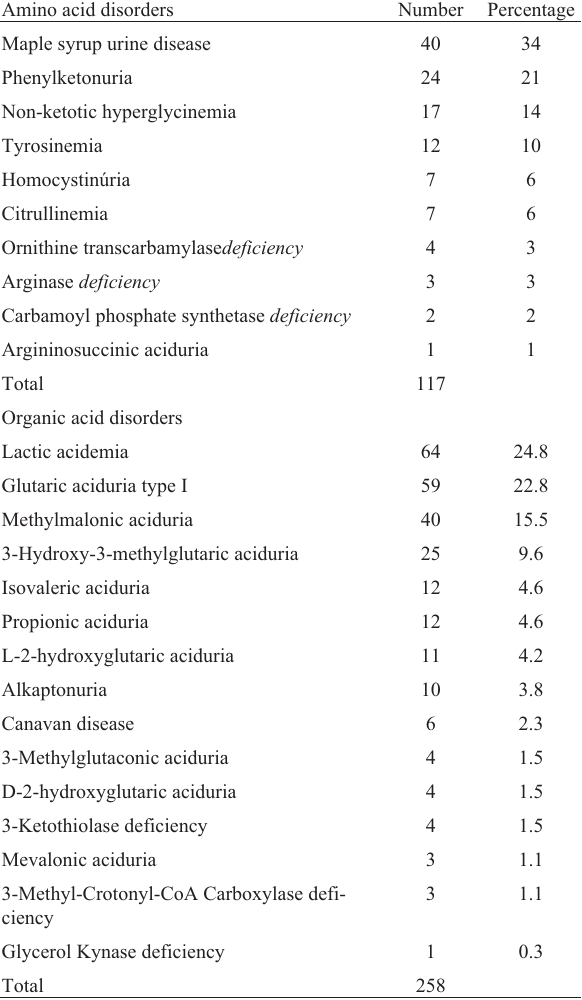
Table 3 - Number and types of aminoacidopathies and organic acidurias detected in high-risk Brazilian patients from 2006 to 2016. Amino acid disorders Number